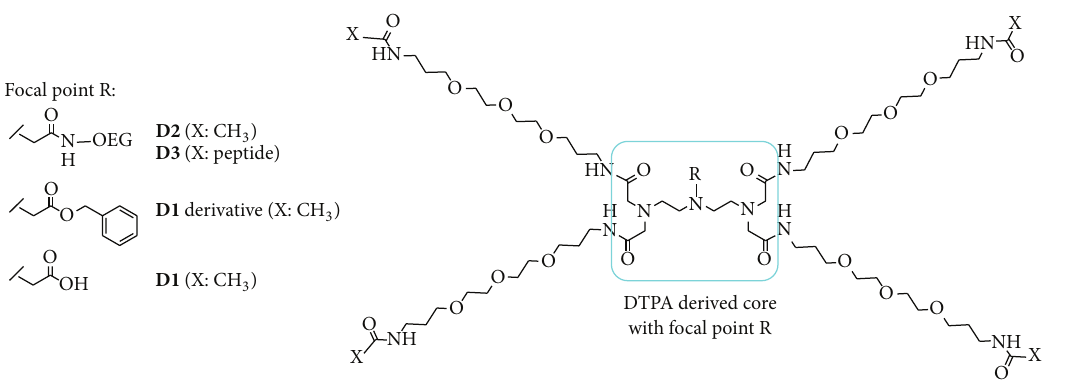
Figure 2: Molecular structure of first generation OEG-DTPA dendron. The focal point of the DTPA moiety is indicated with R and can consist of several functional groups.